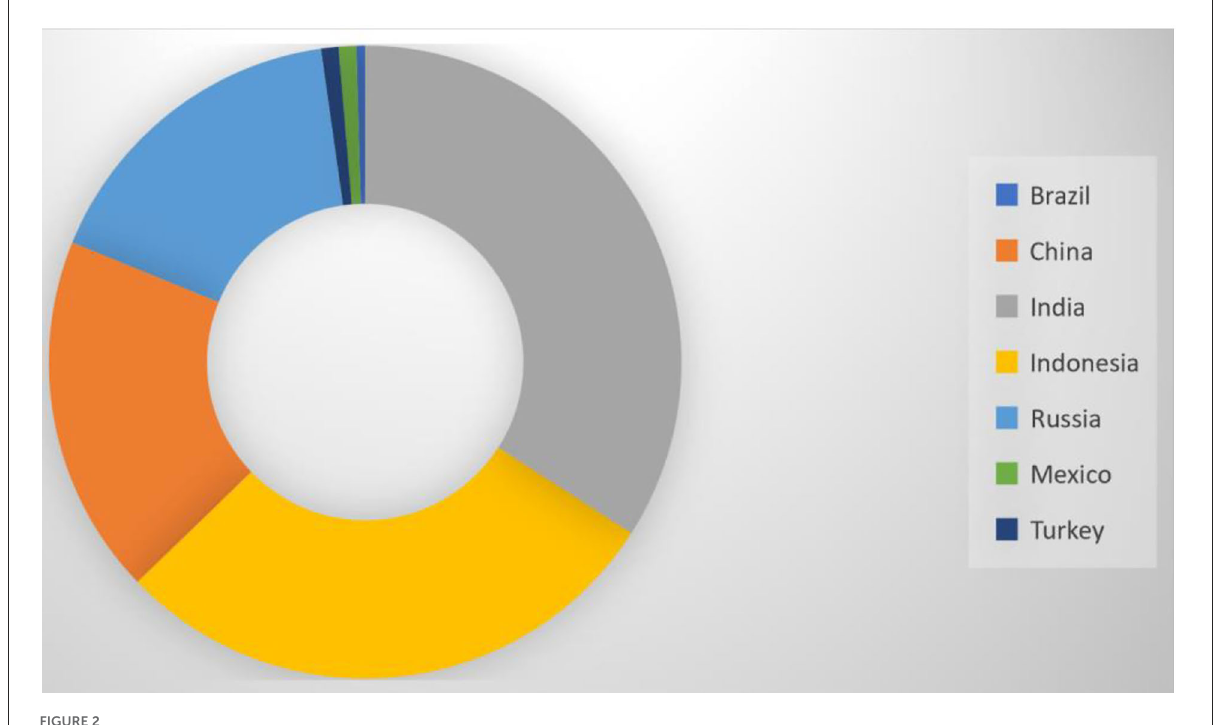
FIGURE2 Coal rent of E7